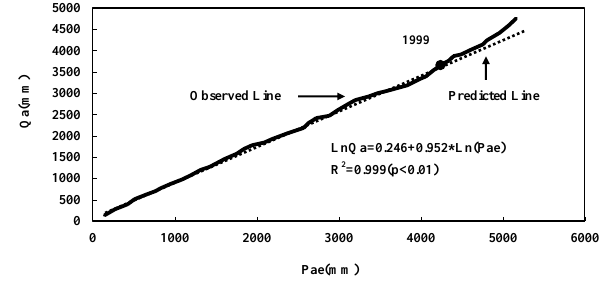
Figure 6 Modified Double mass curve of accumulated annual mean flow (Q a ) and 983 Fig. 6. Modified double mass curve.